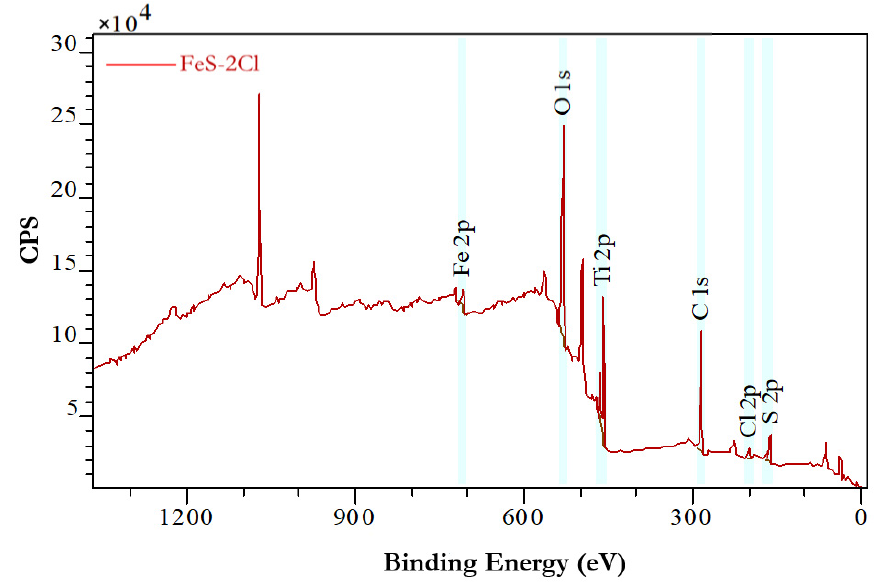
Figure 9. XPS spectrum for FeS–2Cl catalyst.